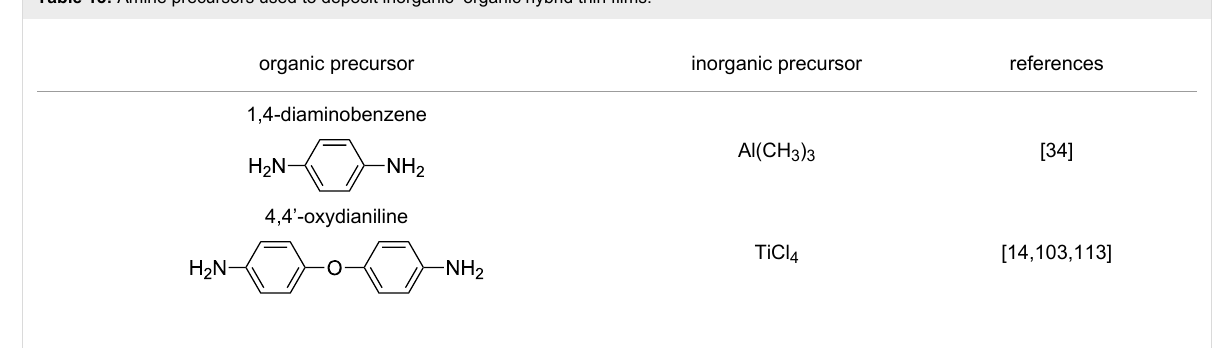
Table 13: Amine precursors used to deposit inorganic–organic hybrid thin films.